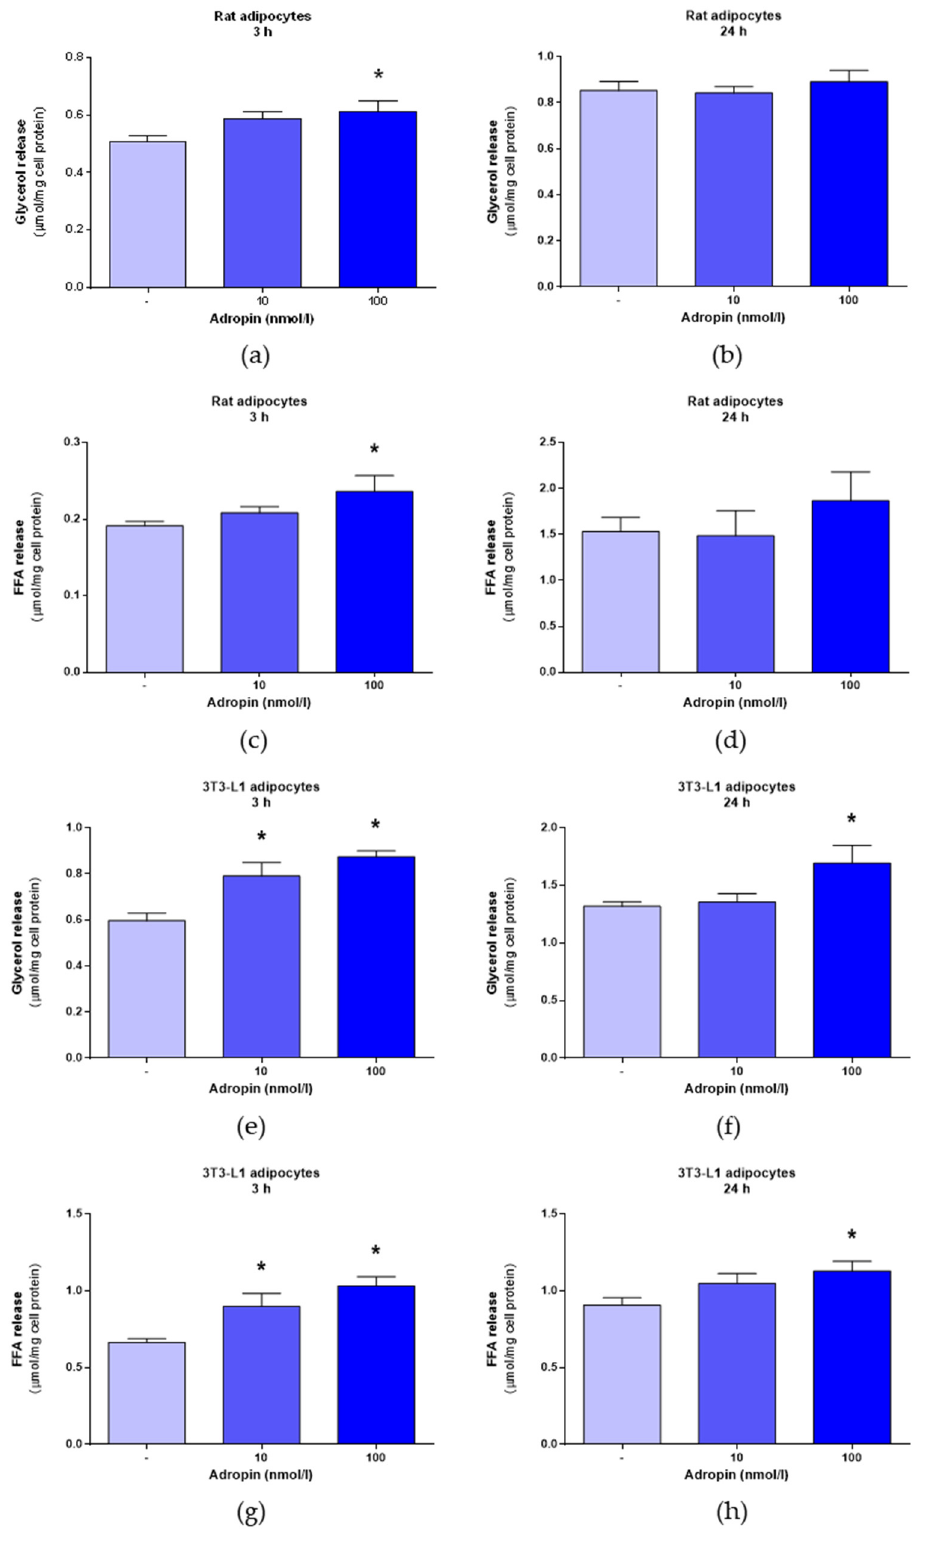
Figure 2. The effects of adropin (10 or 100 nmol/L) or vehicle (sterile distilled water) (-) on lipolysis in rat primary adipocytes and 3T3-L1 adipocytes. The effects of adropin (10 or 100 nmol/L) on glycerol release in rat adipocytes assessed after 3 ( a ) or 24 h ( b ) of incubation. FFA release determined in rat adipocytes exposed to adropin for 3 ( c ) and 24 h ( d ). The effects of adropin on glycerol release in 3T3-L1 cells treated with adropin for 3 ( e ) or 24 h ( f ). Secretion of FFA from 3T3-L1 incubated in the presence of adropin for 3 ( g ) or 24 h ( h ). Results are the mean ± SEM (n = 5–6). p < 0.05